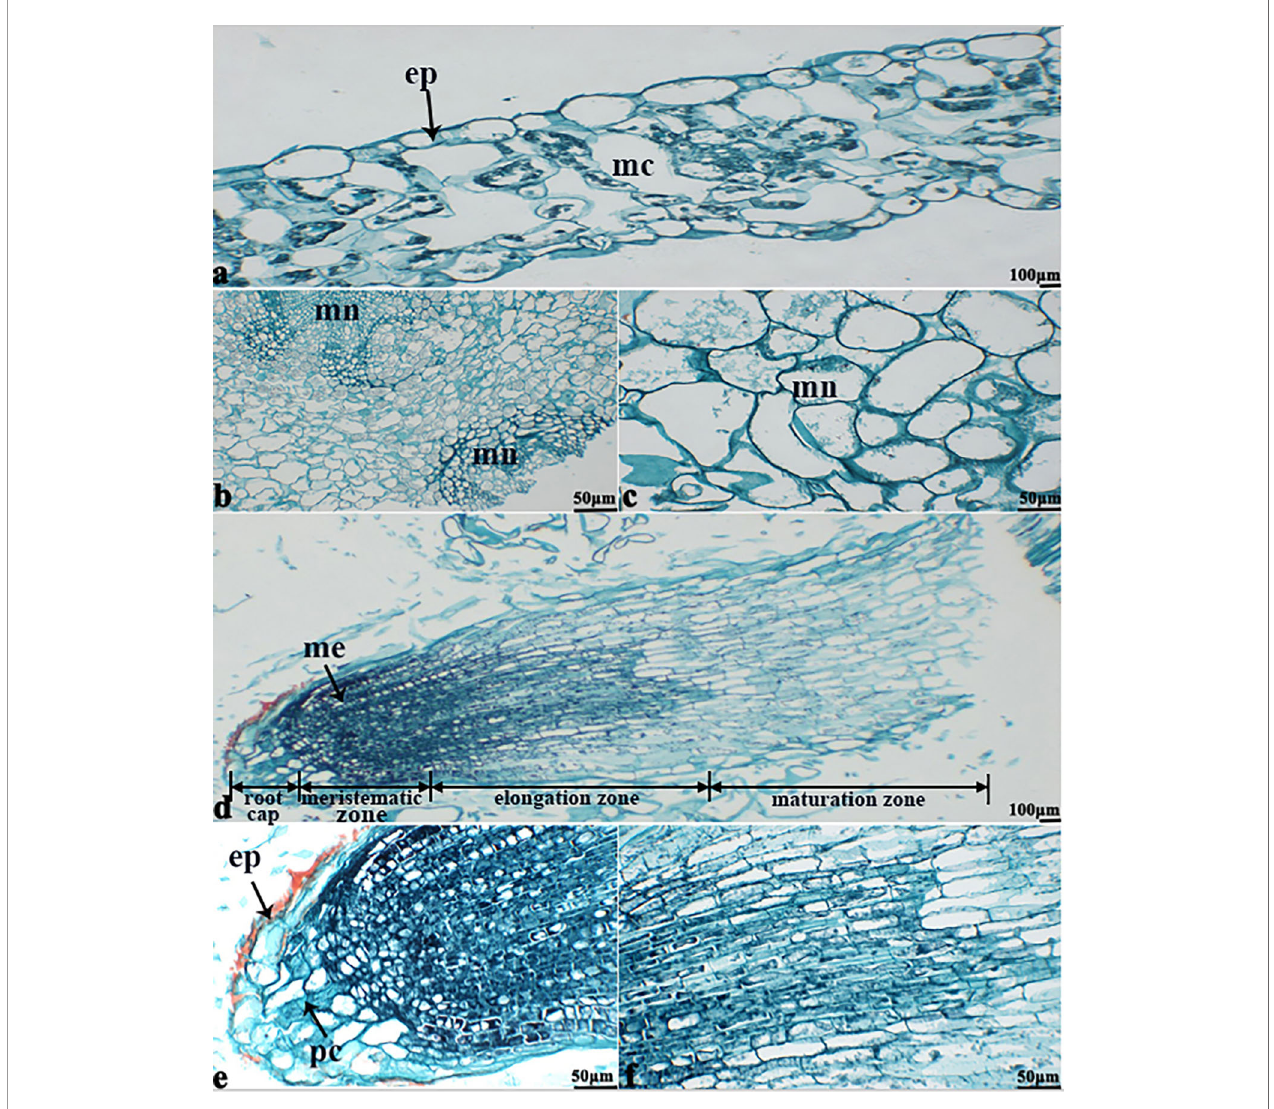
FIGURE 12 | The deepest leaf (A) , callus (B, C) , root (D – F) samples with blue formazan precipitate areas from the callus of cultivar Tianyou2238 were sectioned for morphoanatomical analyses. ep, epidermis; mc, mesophyll cell; mn, meristematic nodule; me, meristem; pc, parenchymal cell. Scale bars = 50 µm and 100